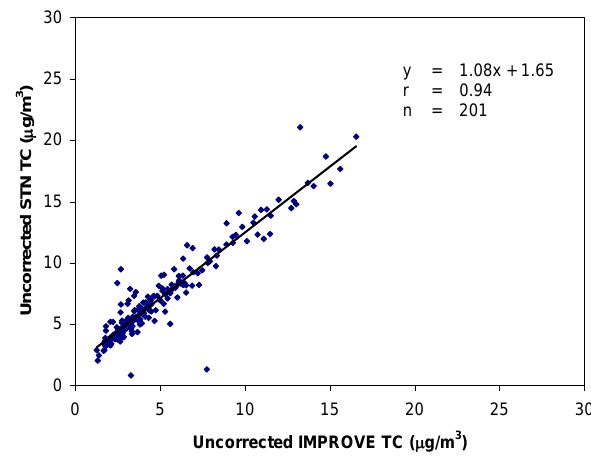
Fig. 7. Linear regression of uncorrected STN/CSN TC vs. IMPROVE TC acquired from the Phoenix, AZ site (PHOE1). The non-zero intercept indicates sampling artifacts between STN/CSN and the IMPROVE network.